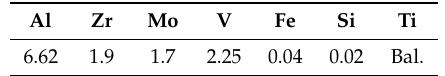
Table 1. The chemical composition of TA15 titanium alloy powders